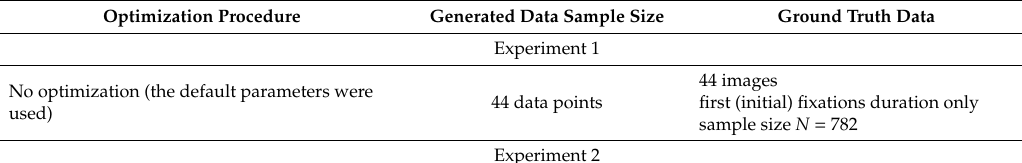
Table 2. Summary of the optimization procedure parameters used in the